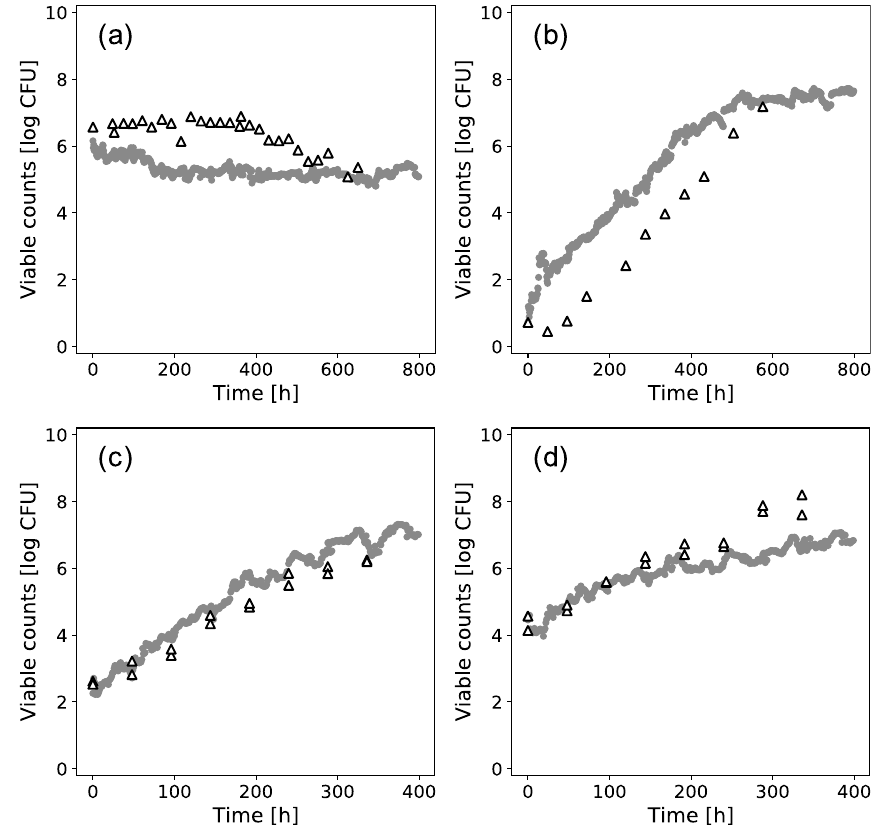
Figure 5. Comparison between the observed and predicted behavior of Listeria monocytogenes in culture medium with pH 4.5 and a w 0.997 at 5 °C ( a ), in culture medium with pH 7.3 and a w 0.997 at 4 °C ( b ), and in tuna at 6 °C with initial cell numbers of 2.6 ( c ) and 4.3 (log CFU) ( d ). Predicted results are plotted as a circle. The observed results are plotted as a